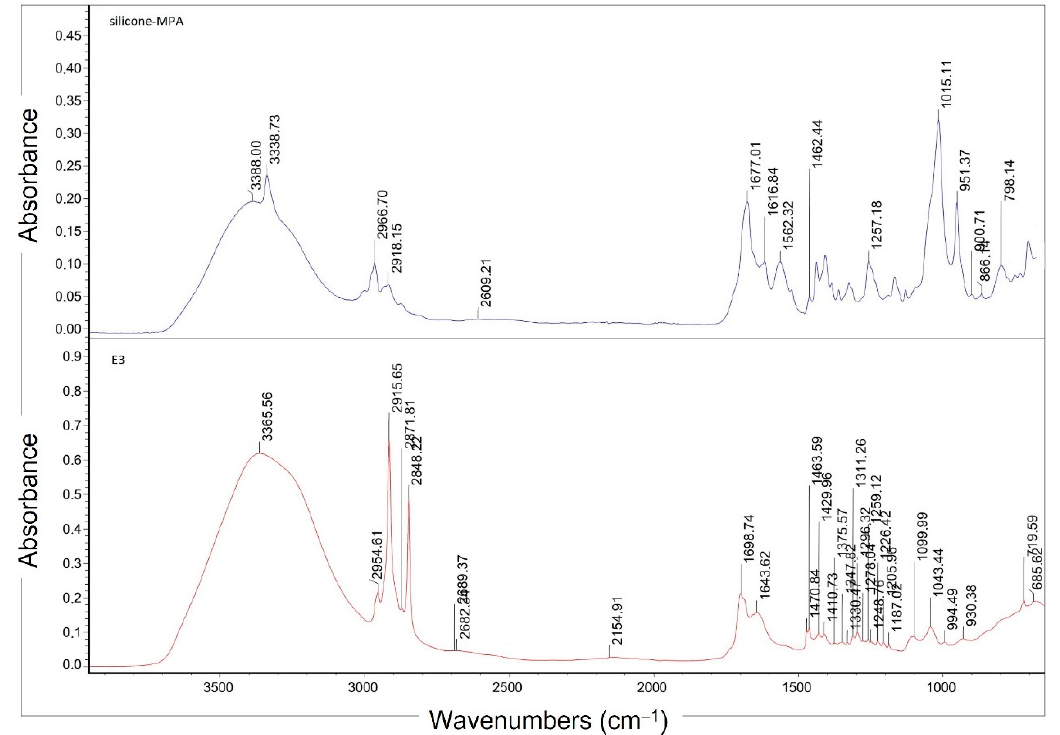
Figure 13. FTIR spectra of silicone-MPA (blue) and sample E3 (red).